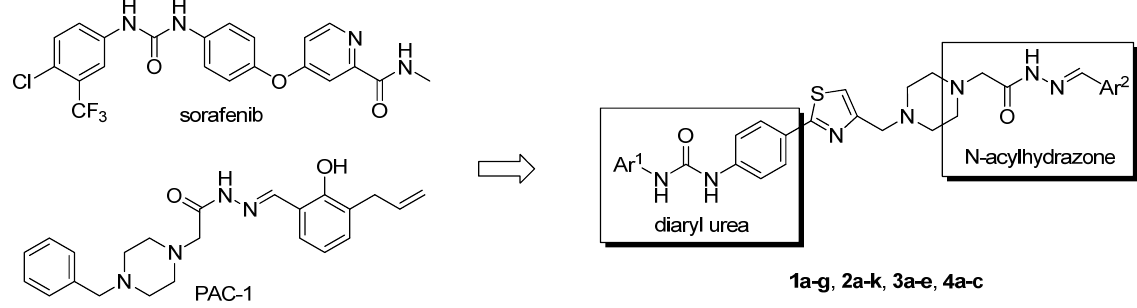
Figure 1. Structures of sorafenib, PAC-1 and target